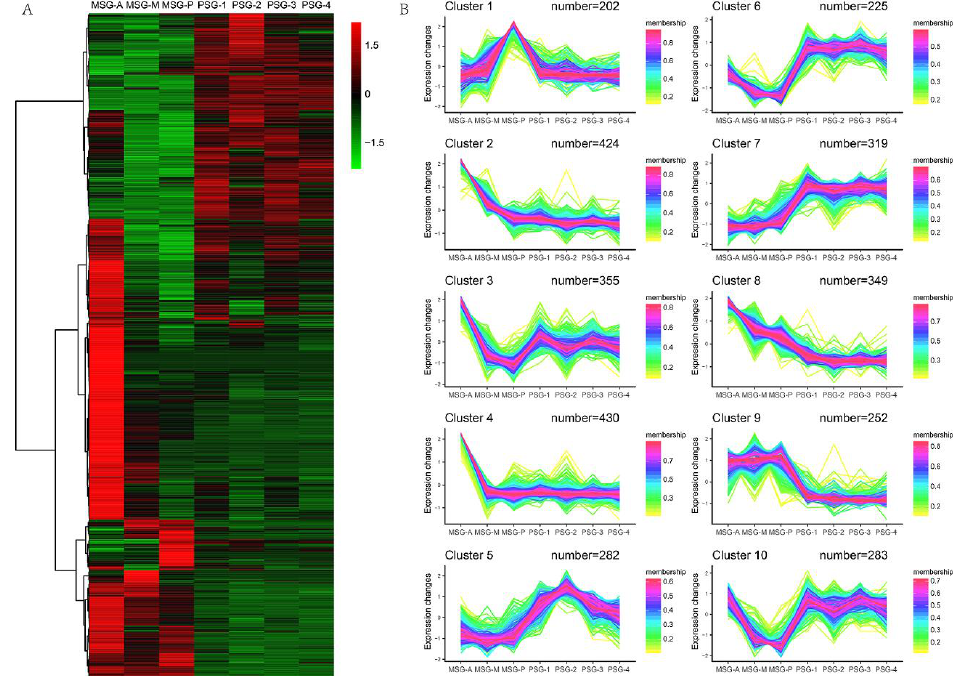
Figure 2. Cluster analysis of all di ff erentially expressed genes (DEGs) between single silk gland samples. ( A ) Hierarchical clustering of DEGs. Red, high expression level; Green, low expression level. DEGs, di ff erentially expressed genes. ( B ) Coexpression analysis of DEGs. Red, high correlation; yellow, low correlation.